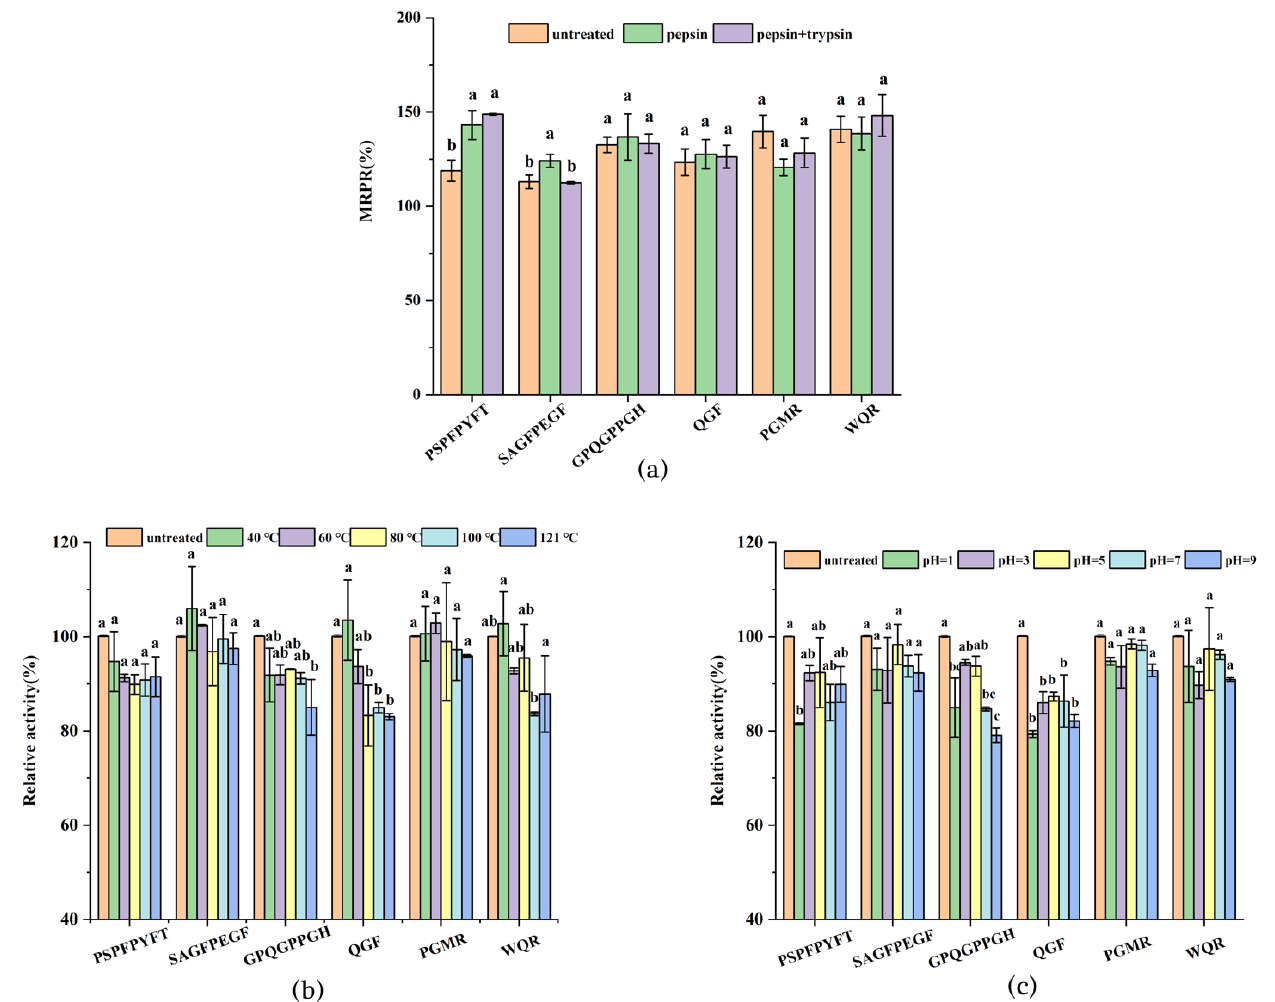
Figure 5. Stability analysis of synthetic peptides. Effects of gastrointestinal digestion ( a ), heat treatment ( b ), and pH treatment ( c ) on the relative proliferation rate of macrophages. Values in columns a – d with different superscripts indicate significant differences ( p < 0.05).